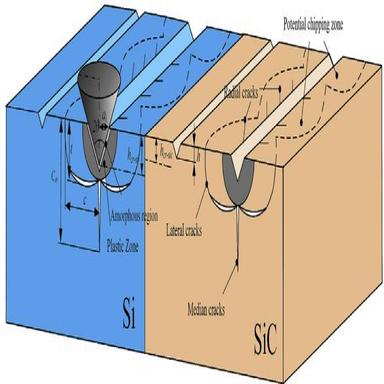
Schematic diagram of RB-SiC surface features produced in grinding.